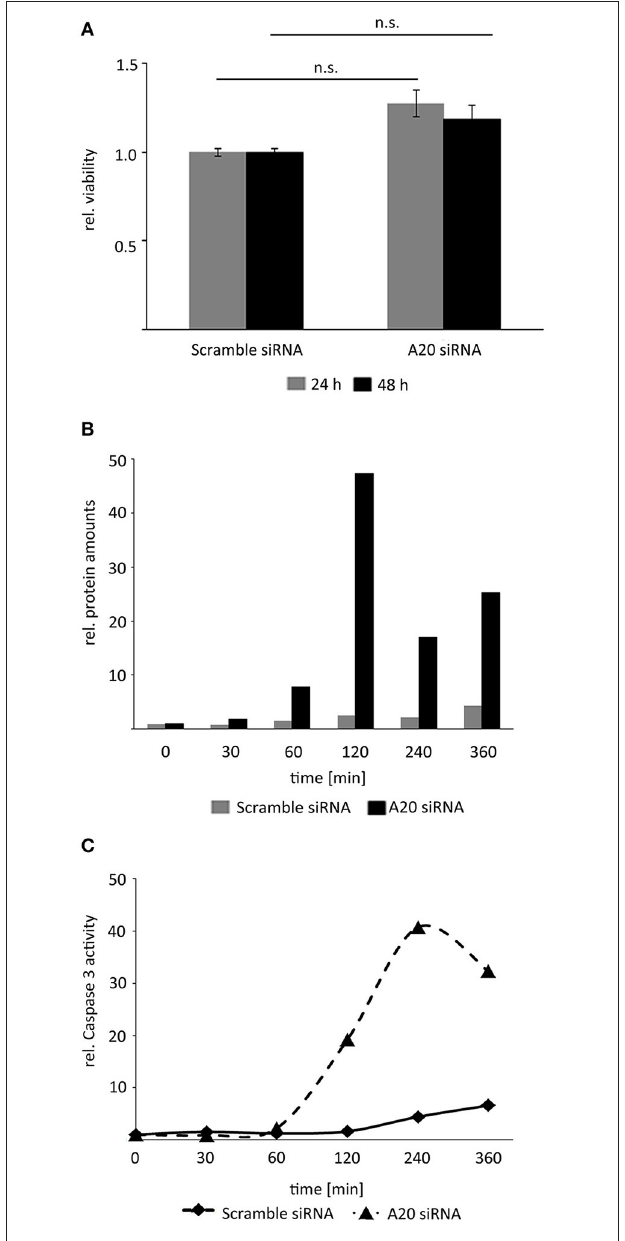
FIGURE 6 | Reduction of A20 sensitizes hepatocellular cells to TNF-induced apoptosis. (A) MTT viability assay illustrated that inhibition of A20 by siRNA did not affect the viability of Hepa1-6 cells after 24 and 48 h. (B) Measurement of caspase-3 fragments after A20 inhibition and TNF stimulation by Western immunoblotting. Exemplary results after densitometric quantification are shown. An independent repetition led to similar results. (C) Measurement of caspase-3 activity after A20 silencing followed by TNF stimulation. Exemplary results after fluorometric measurement are shown. An independent repetition led to similar